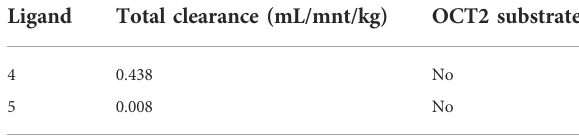
TABLE 9 The excretion pro fi le evaluation results of the